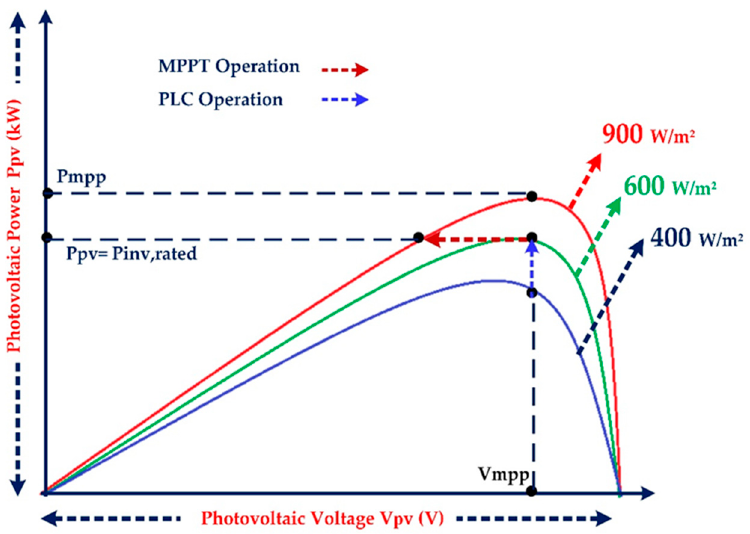
Figure 30. PV system with oversized PV arrays using MPPT and PLC.